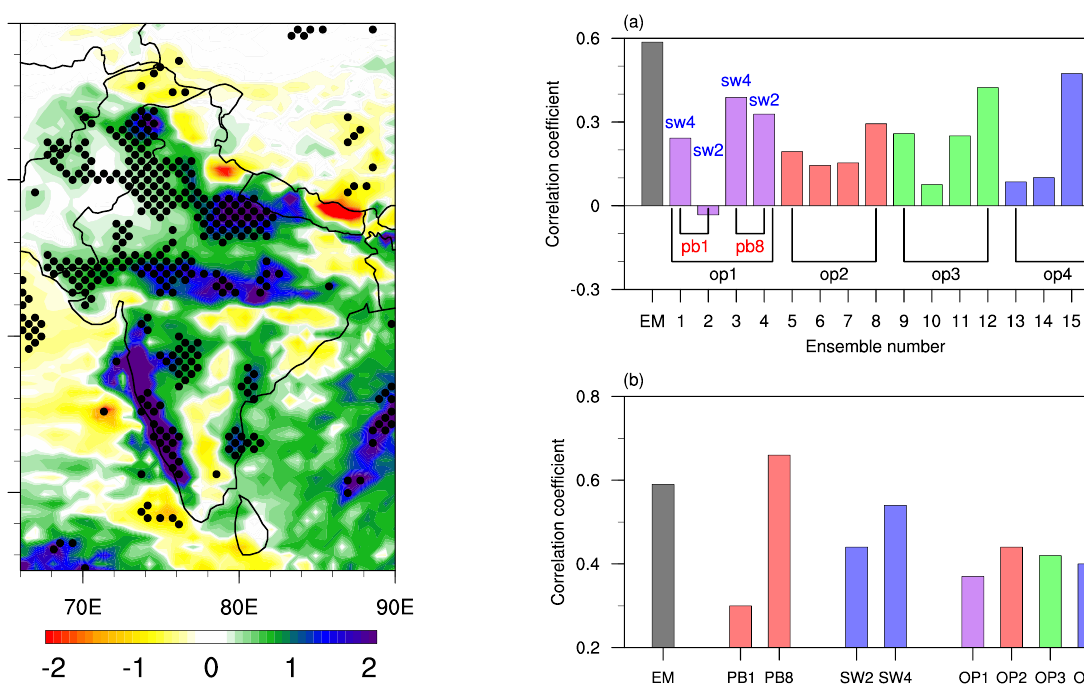
Figure 6. Spatial pattern of WRF-Chem ensemble mean differences in rainfall (mmday − 1 ) between ALLF and NDST experiments dur- ing JJA 2008. Areas that have a 90% confidence level based on a one-sided Student’s t test are indicated by dots.